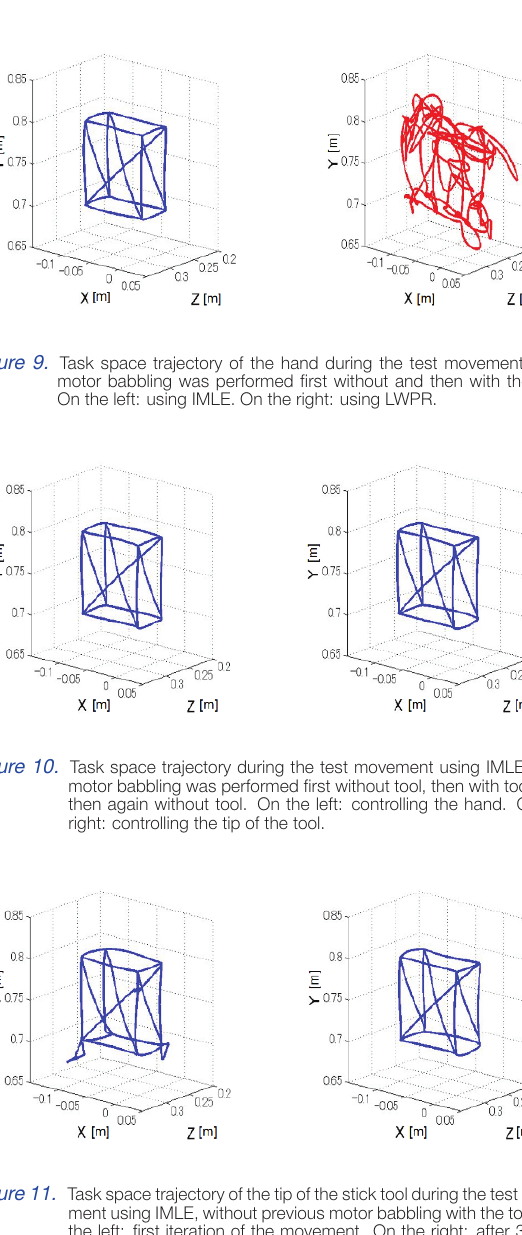
of this estimation with respect to given test sets (Section 7.1). Then we show how the learned kinematic model can be used for task space control, realizing two di(cid:636)erent behaviors: arm-head coordination (Sec- tion 7.2) and visually guided reaching (Section 7.3). All the described